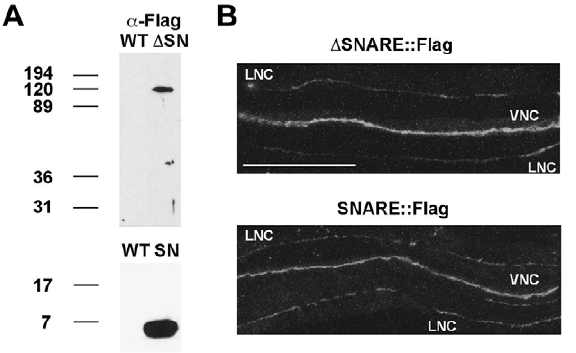
Figure 4. Flag-tagged TOM-1A SNARE and D SNARE transgenics phenocopy untagged lines. A. Representative evoked response traces for SNARE::FLAG (SY1232) and D SNARE::FLAG (SY1233) express- ing lines. B. Plots of average evoked amplitude and ( C ) evoked charge integral. All data are expressed as mean 6 SEM, the sample size (n) is indicated as a number in each bar. Mann Whitney T-tests showed values were not significantly different.